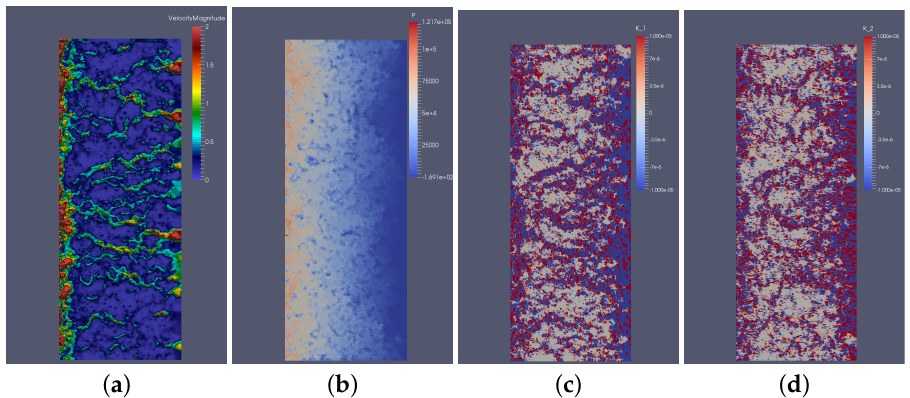
Figure 8. A SPH simulation of a 2D slice of a synthetically generated hydrogel showing: ( a ) Filtration velocity magnitude; ( b ) Pressure field; ( c ) Hydraulic conductivity coefficient in horizontal direction [ κ ] 0 11 , and ( d ) in vertical direction